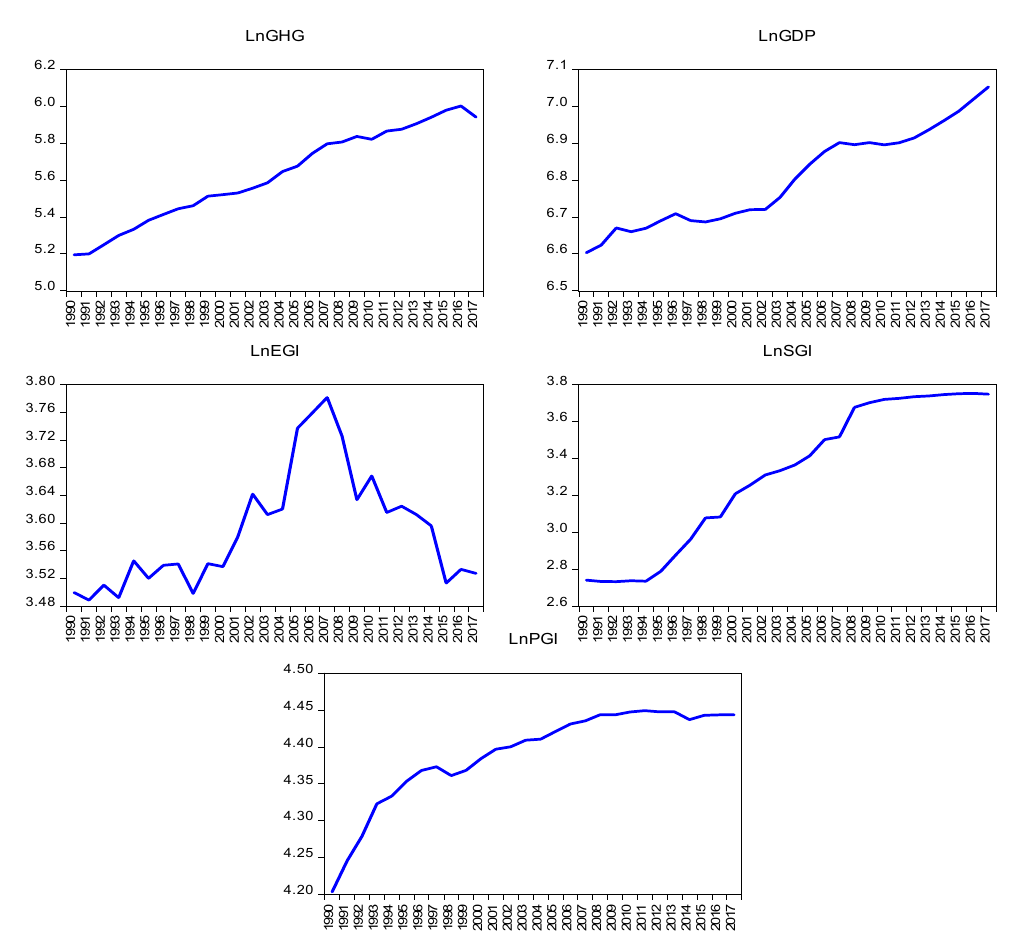
Figure 2. The trend of the series. Table 2. Results of unit root